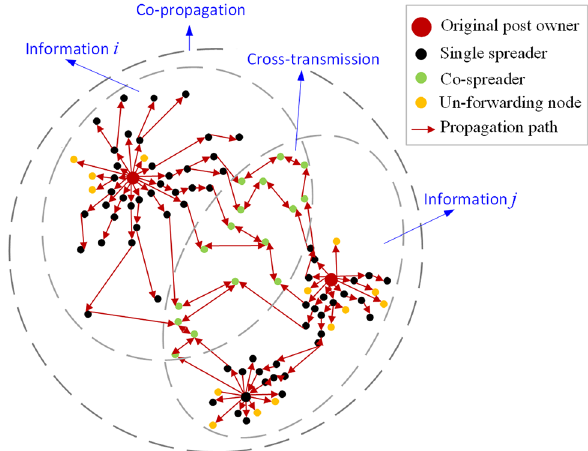
Figure 2. A schematic diagram for co-propagation by two relative